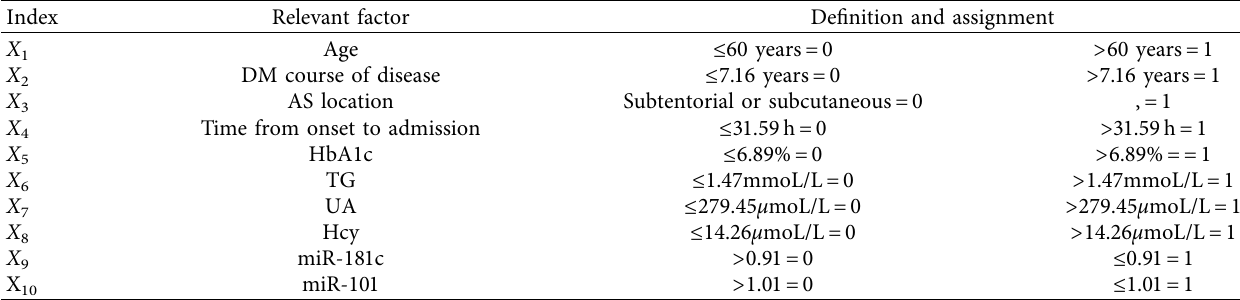
Table 2: Assignments of study variables.